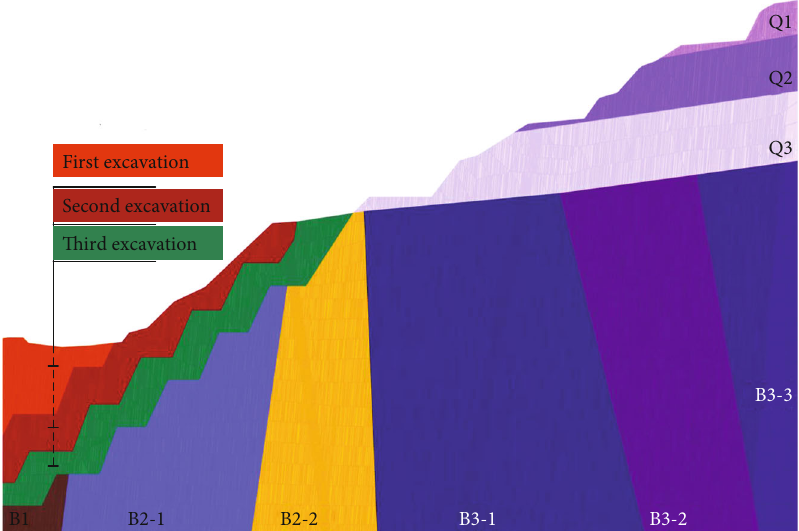
Figure 6: Typical cross section of the mining